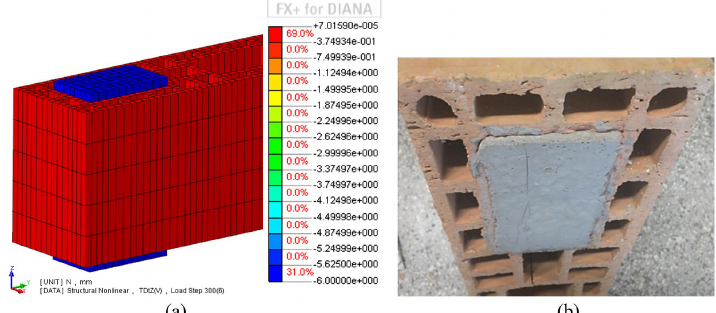
Figure 11. Displacement of the grout according to the ClG14 series (a) numerical model and (b) bottom face of the physical model.